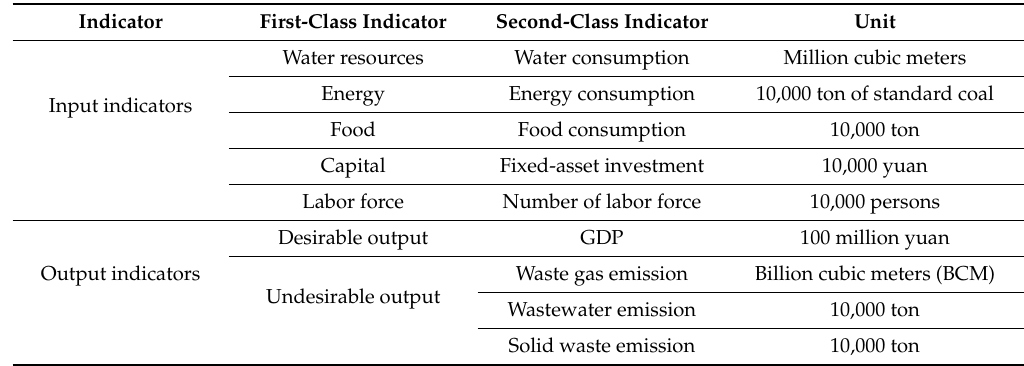
Table 1. Evaluation index system of the total factor productivity (TFP) of the water–energy–food (WEF) nexus in Inner Mongolia